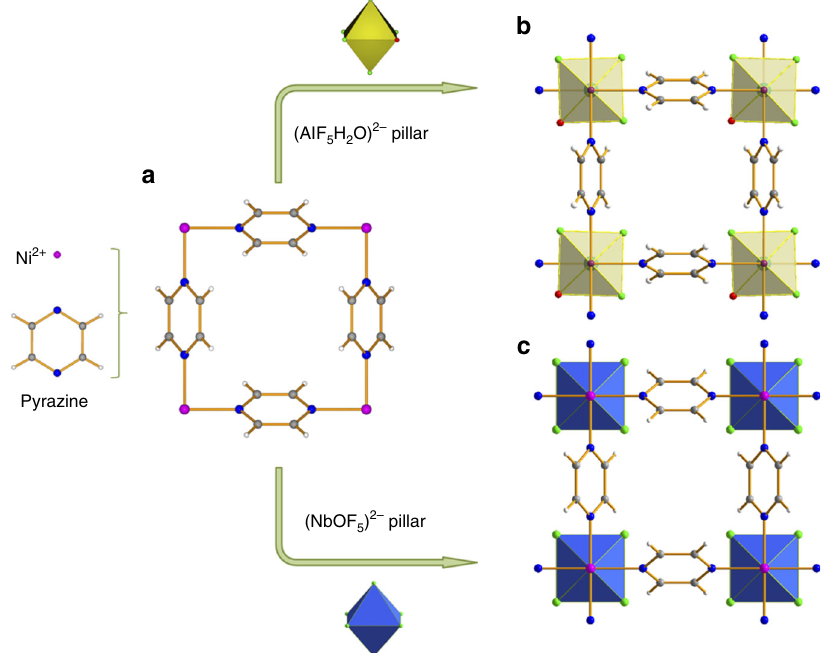
Fig. 1 Synthesis and crystal structure of KAUST-7 and KAUST-8. a [Ni(pyrazine) 2 ] 2 + square grid resulting from the connection of Ni 2 + cations and pyrazine molecules. b Crystal structure of KAUST-8 resulting from the pillaring of [Ni(pyrazine) 2 ] 2 + square grid with (AlF 5 (OH 2 )) 2 − pillar. c Crystal structure of KAUST-7 resulting from the pillaring of [Ni(pyrazine) 2 ] 2 + square grid with (NbOF 5 ) 2 −